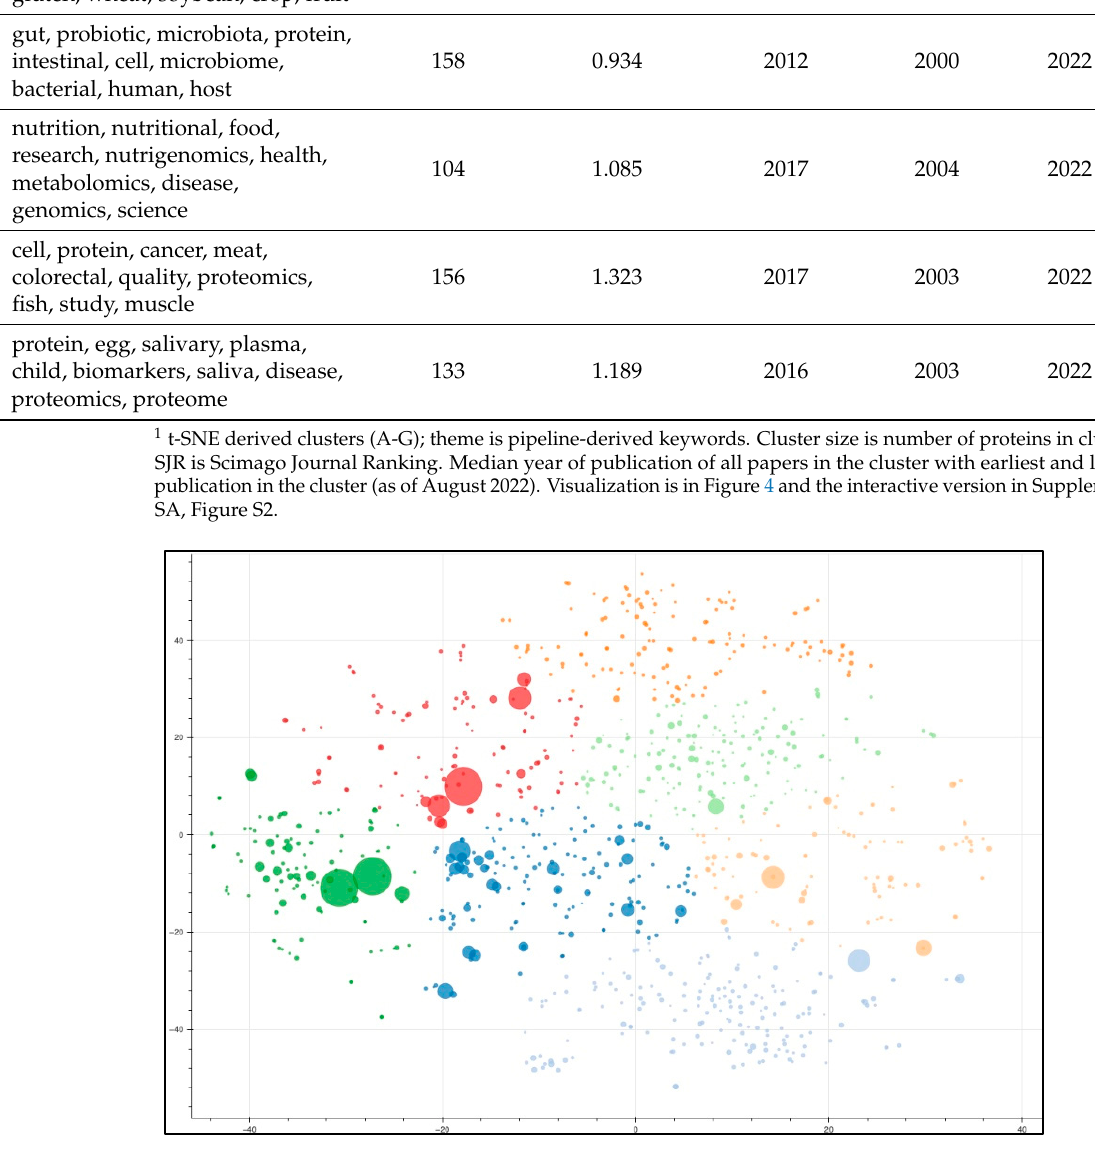
Figure 4. t-SNE cluster and visualization of nutrition-proteomic research themes. Each dot refers to